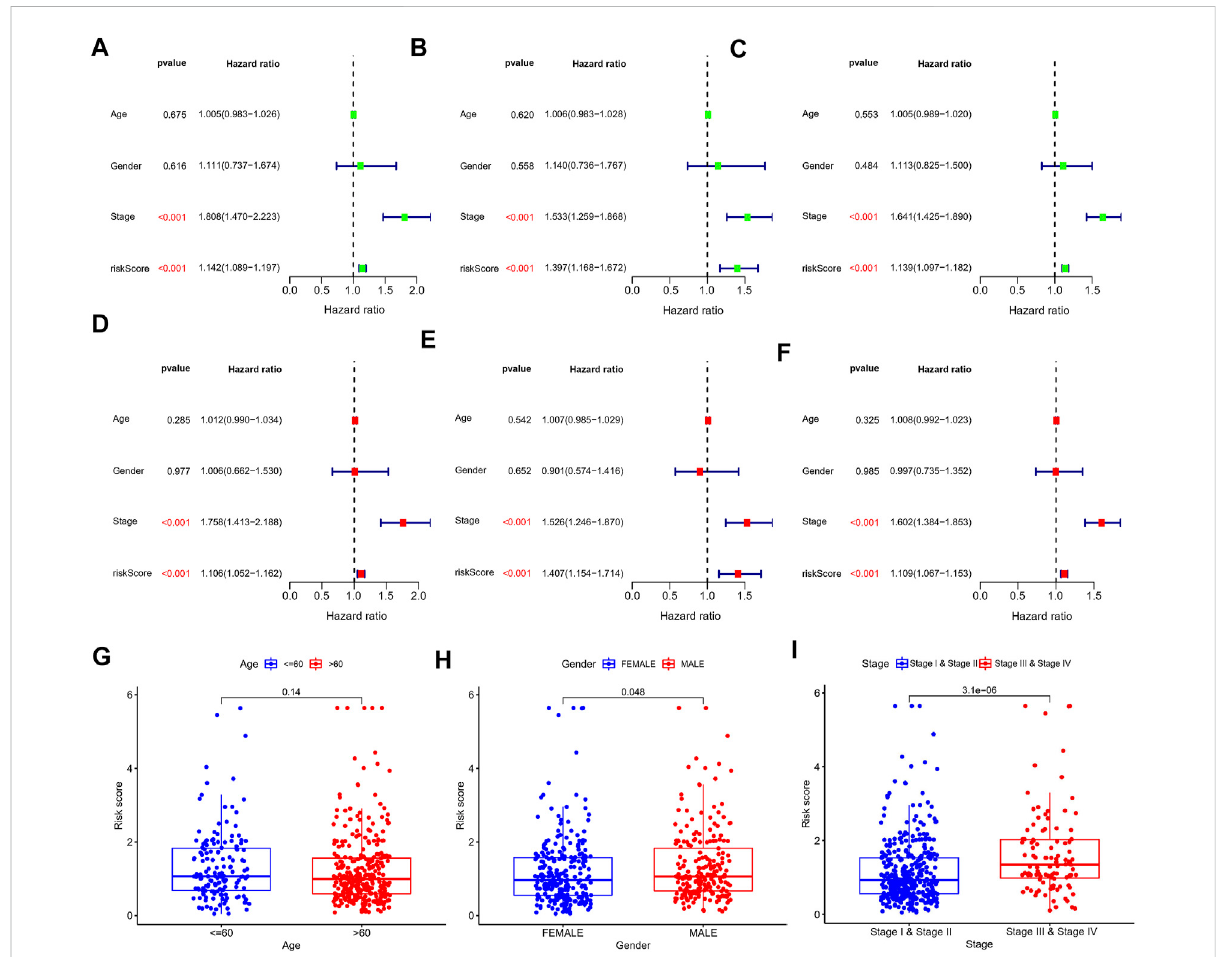
FIGURE 5 Univariate and multivariate Cox regression analysis in the train, test, and entire set, respectively. (A – C) Univariate Cox regression analysis in the train,test,andentireset,respectively. (D – F) MultivariateCoxregressionanalysisinthetrain,test,andentireset,respectively. (G – I) Distributionofrisk score strati fi ed by age, gender and clinical stage in entire